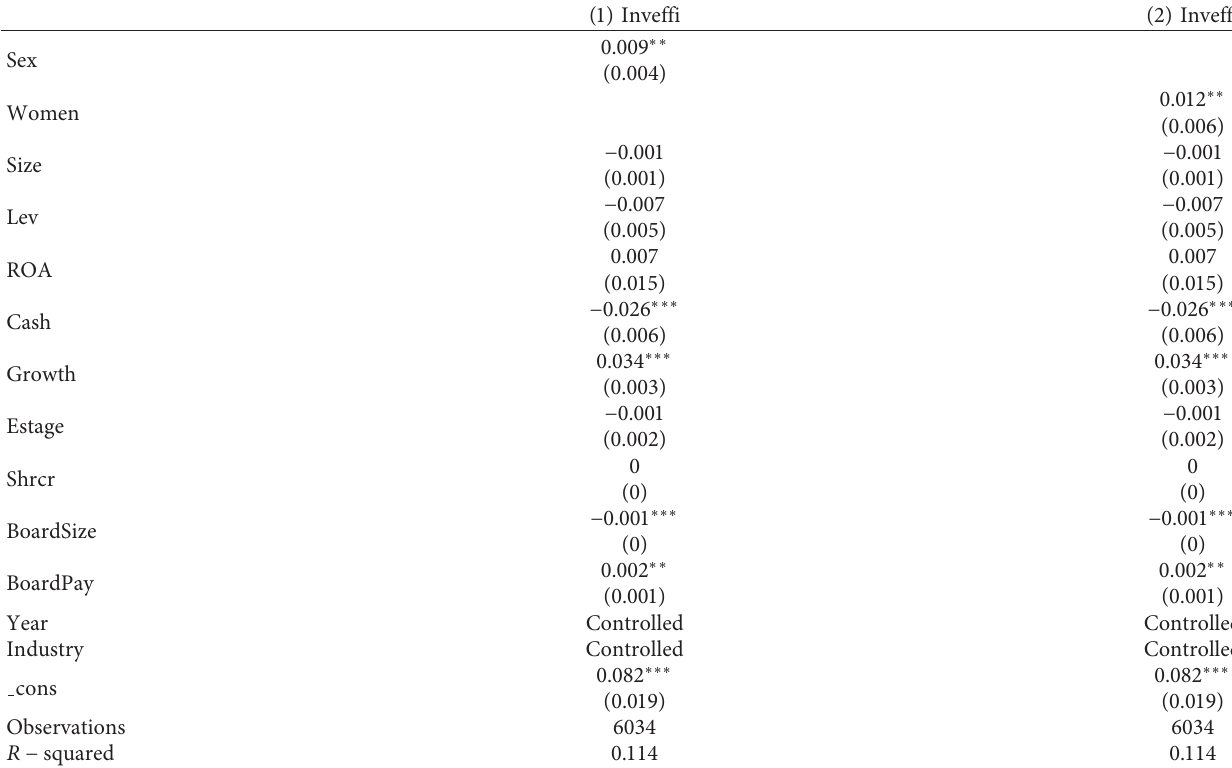
Table 6: Regression results of the relationship between sex characteristics of board members and investment efficiency of refinancing